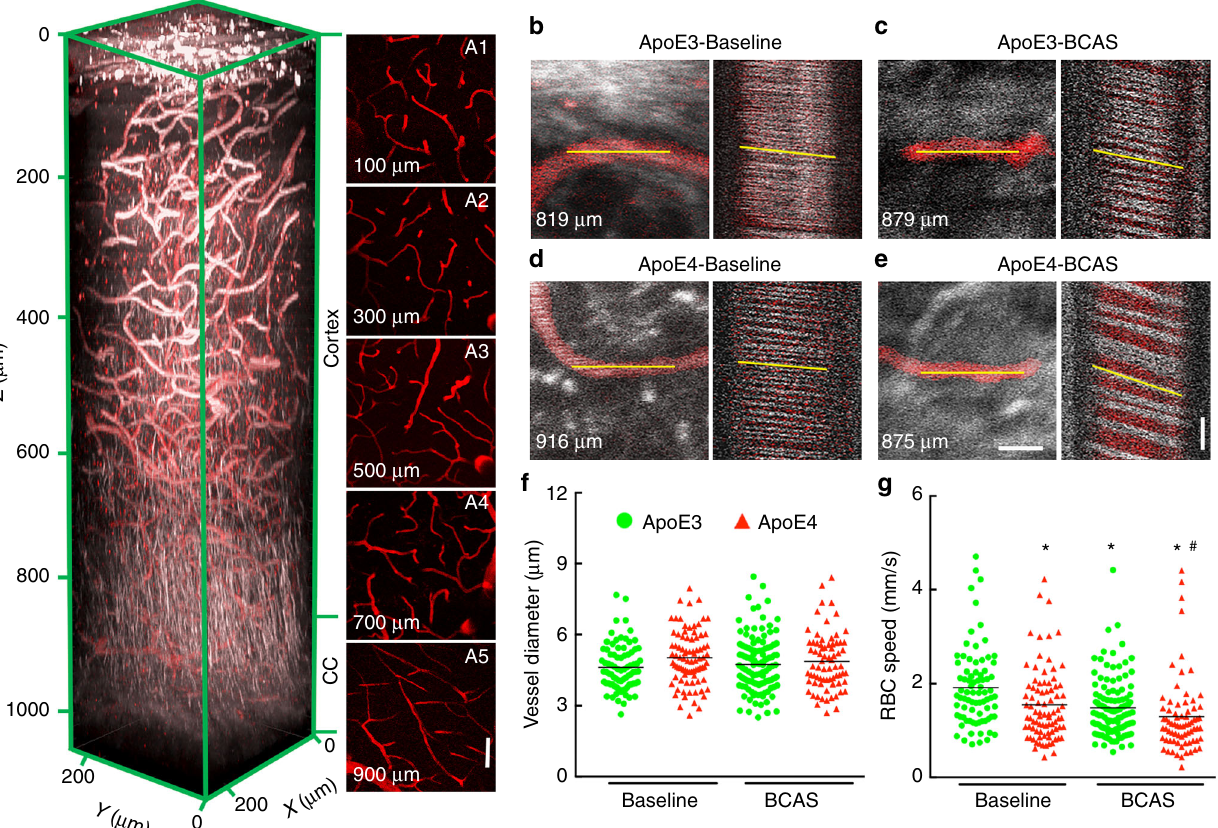
Fig. 4 Reduced CC fl ow in ApoE4-TR mice before and after BCAS. a Rendering of in vivo 3-photon excited fl uorescence/third harmonic generation (3PEF/ THG) image stack that spans from the cortical surface to the white matter (WM) of the corpus callosum (CC) in ApoE3-TR mice. The vasculature was visualized by the THG signal (white), and was also labeled with FITC-dextran (red). The images to the right (A1 – A5) show 40- µ m thick maximal microvascular projections, centered at the indicated depths. Scale bar in A5 = 50 µ m. b – e Projections (20 µ m thick) of 3PEF/THG image stacks and line scans for capillaries in the CC, taken at the indicated depths from the cortical surface, of ApoE3 and ApoE4 mice at baseline and at one month after BCAS. Scale bars in E are 10 µ m and 50 ms, respectively. f , g Plot of diameter ( f ) and RBC fl ow speed ( g ) in individual CC capillaries at the depth between 800 – 1000 µ m in the same mice at baseline and 4 weeks after BCAS (ApoE3 baseline n = 80 in four mice, ApoE4 baseline n = 85 in four mice, ApoE3 BCAS n = 118 in four mice, ApoE4 BCAS n = 73 in three mice). Data are expressed as means ± SEM. * p < 0.05 from ApoE3-Baseline; # p < 0.05